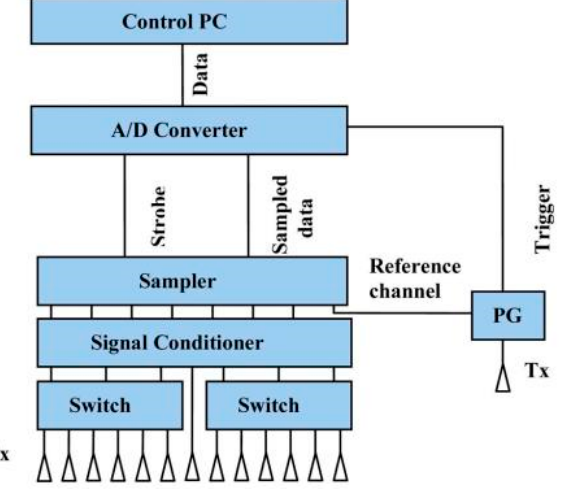
Figure 7. Block diagram of the array radar [60].